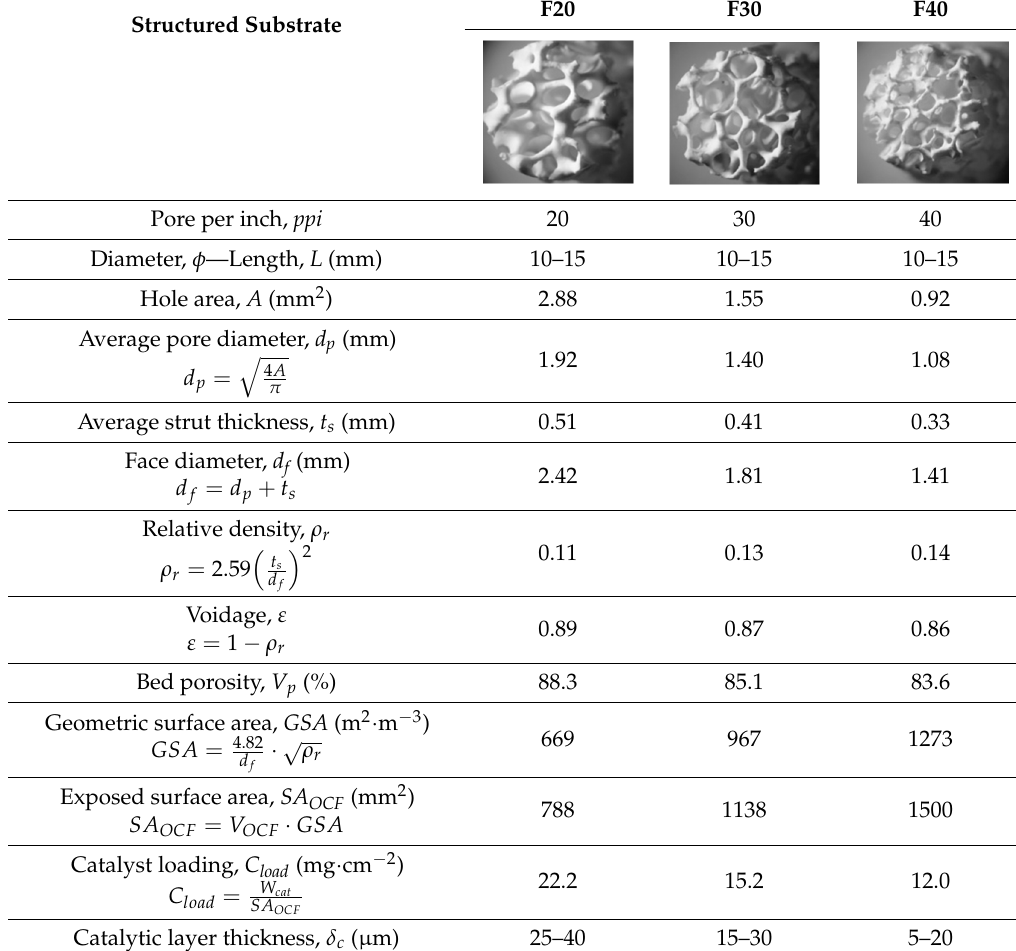
Table 1. Geometrical characteristics of the investigated open cell foam (OCF) structures.